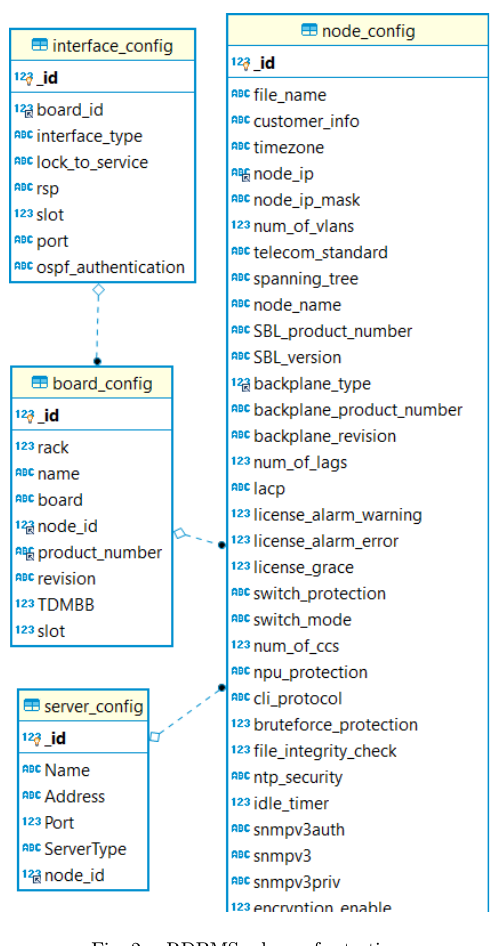
Fig. 2. RDBMS schema for